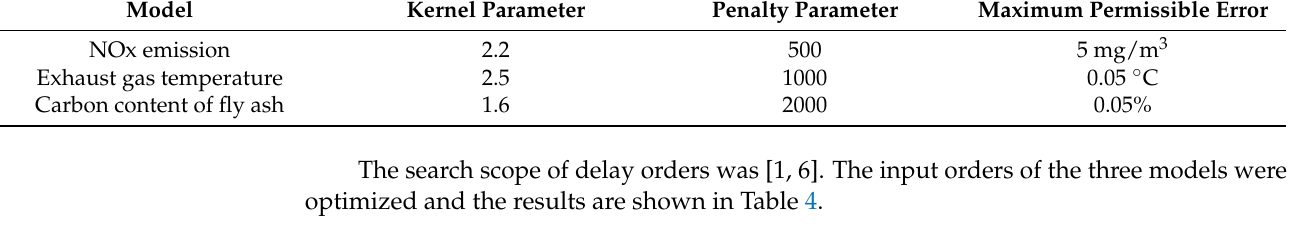
Table 4. Delay orders of the dynamic